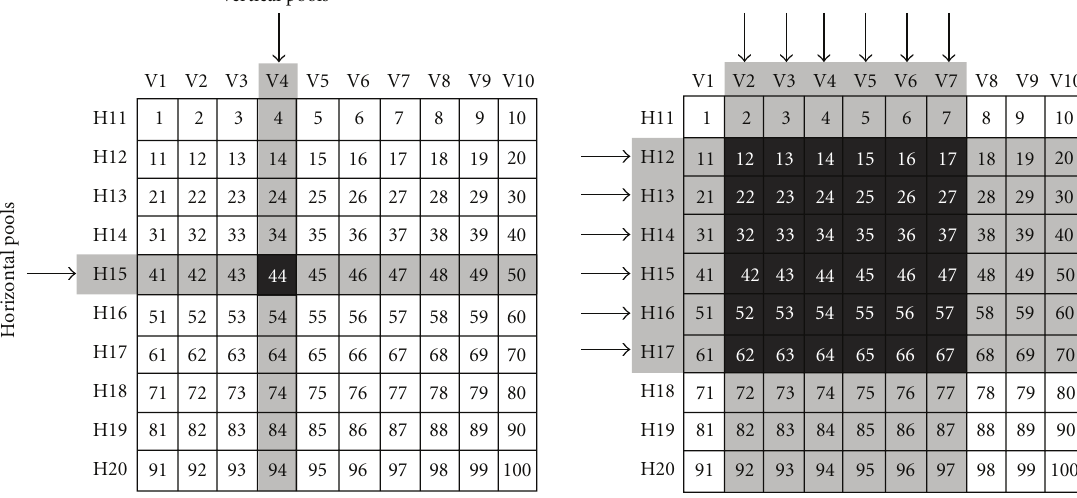
Figure 2: Epitope mapping with peptide matrices. As an example, a panel of 100 peptides is considered. Instead of being tested individually, peptides can be arranged in a matrix of 10 vertical pools (V1-V10) and 10 horizontal pools (H11-H20). The left panel depicts an unambiguous identification. In fact, if peptide 44 only is antigenic, pools V4 and H15 are stimulatory (arrows), thereby pointing at the relevant peptide at the intersection. The right panel depicts an ambiguous identification. In fact, if V2-V7 and H12-H7 pools are stimulatory (arrows), all peptides in the shaded area can be antigenic, but the same result would be obtained if only peptides 12,23,34,45,56,67 were antigenic. Therefore, the intersections of the stimulatory pools could indicate from a minimum of 6 to a maximum of 36 antigenic peptides. This ambiguity would require an additional deconvolution step in which individual peptides identified by the intersection area are individually